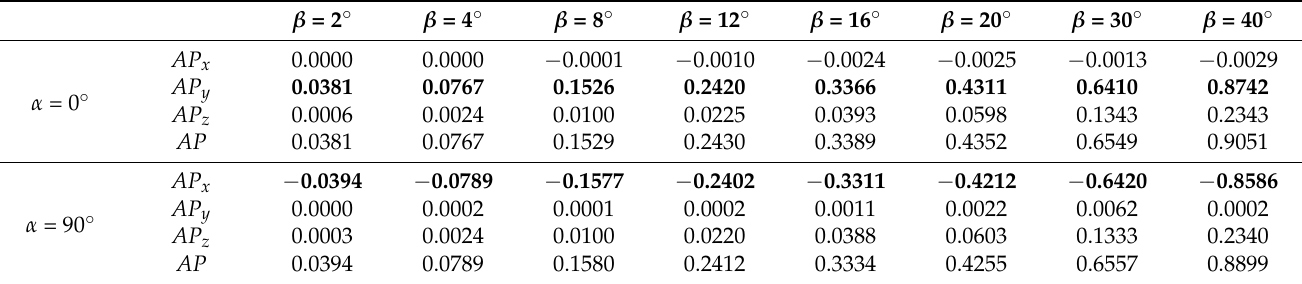
Table 3. Positioning accuracy AP [mm] analysis for Sample 1, Probe